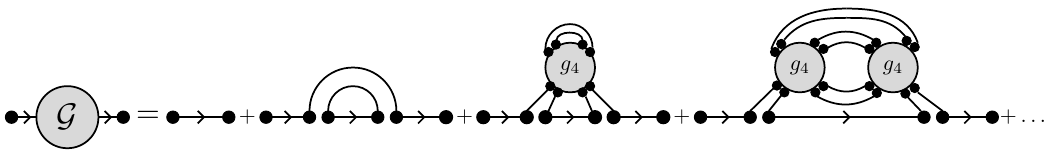
4 contributing to 4 X